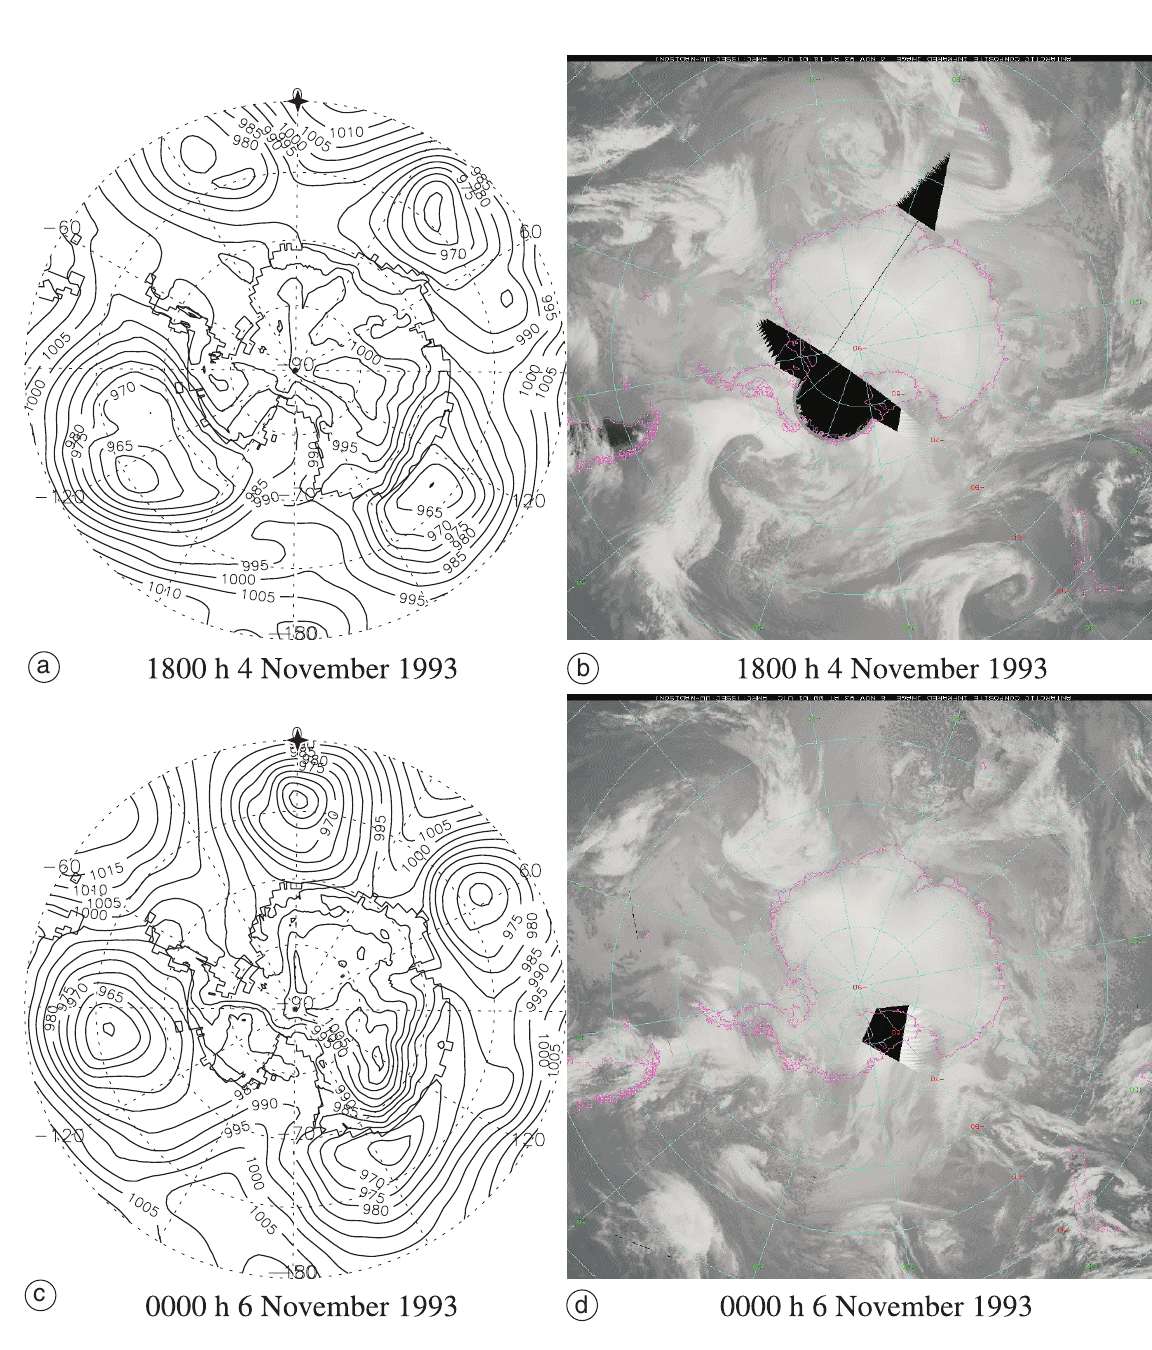
Fig. 5a-d. ECMWF analyses of mean sea level pressure charts and composite infrared satellite images for 1800 h 4 November (a,b) and 0000 h 6 November 1993 (c,d),